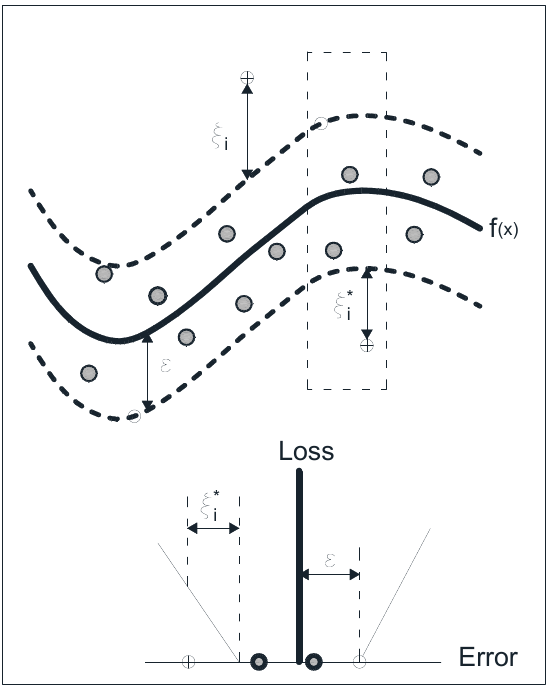
Figure 3. Example of nonlinear Support Vector Regression.